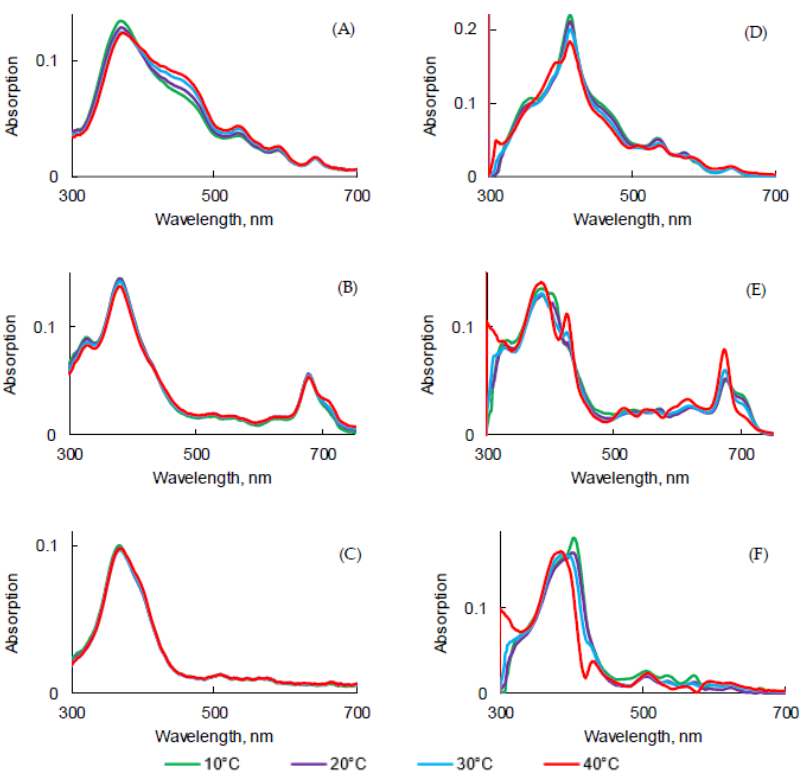
Figure 10. UV-visible absorption spectra ( λ exc = 400 nm for PpIX and PF and 415 nm for PPa) of PpIX ( A , D ), PPa ( B , E ), and PF ( C , F ) in PBS ( A – C ) and FBS ( D – E ) at different temperatures ( c = 3.1 μ M).